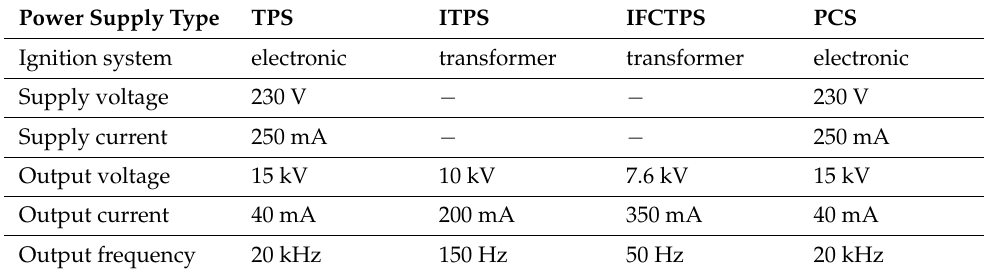
Table 3. Parameters of the reactor ignition electrode supply circuits.